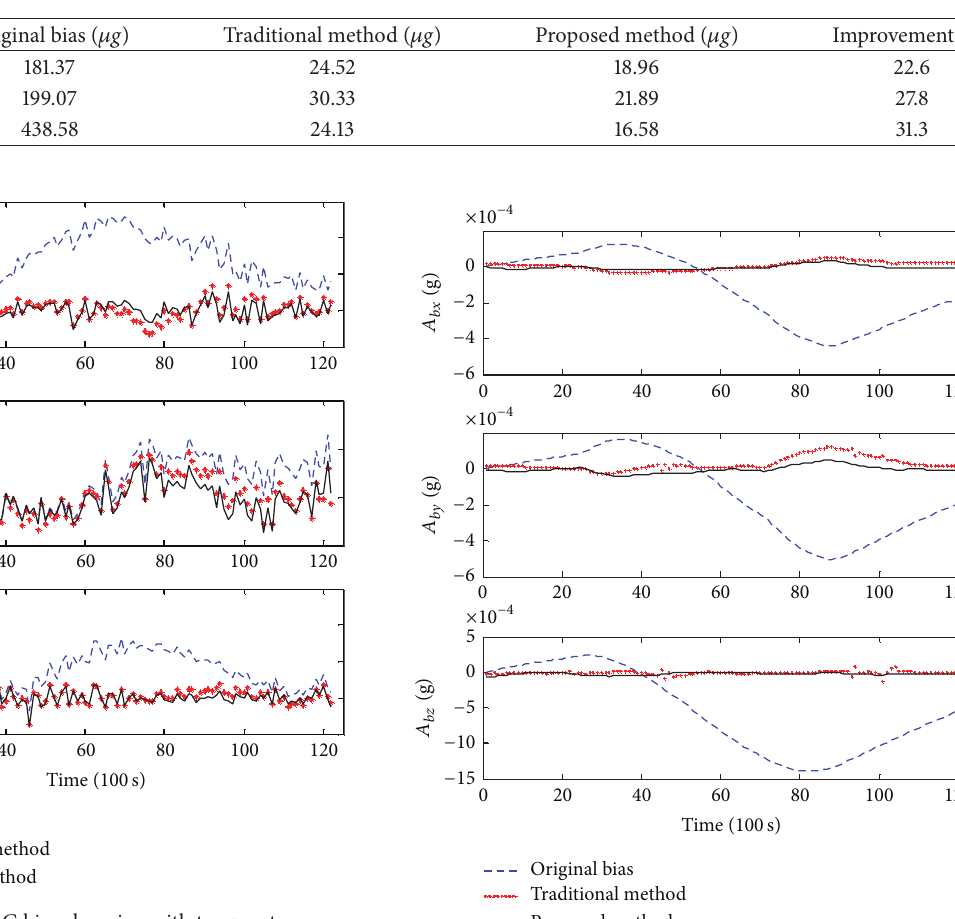
Figure 7: Curves of RLG bias changing with temperature.